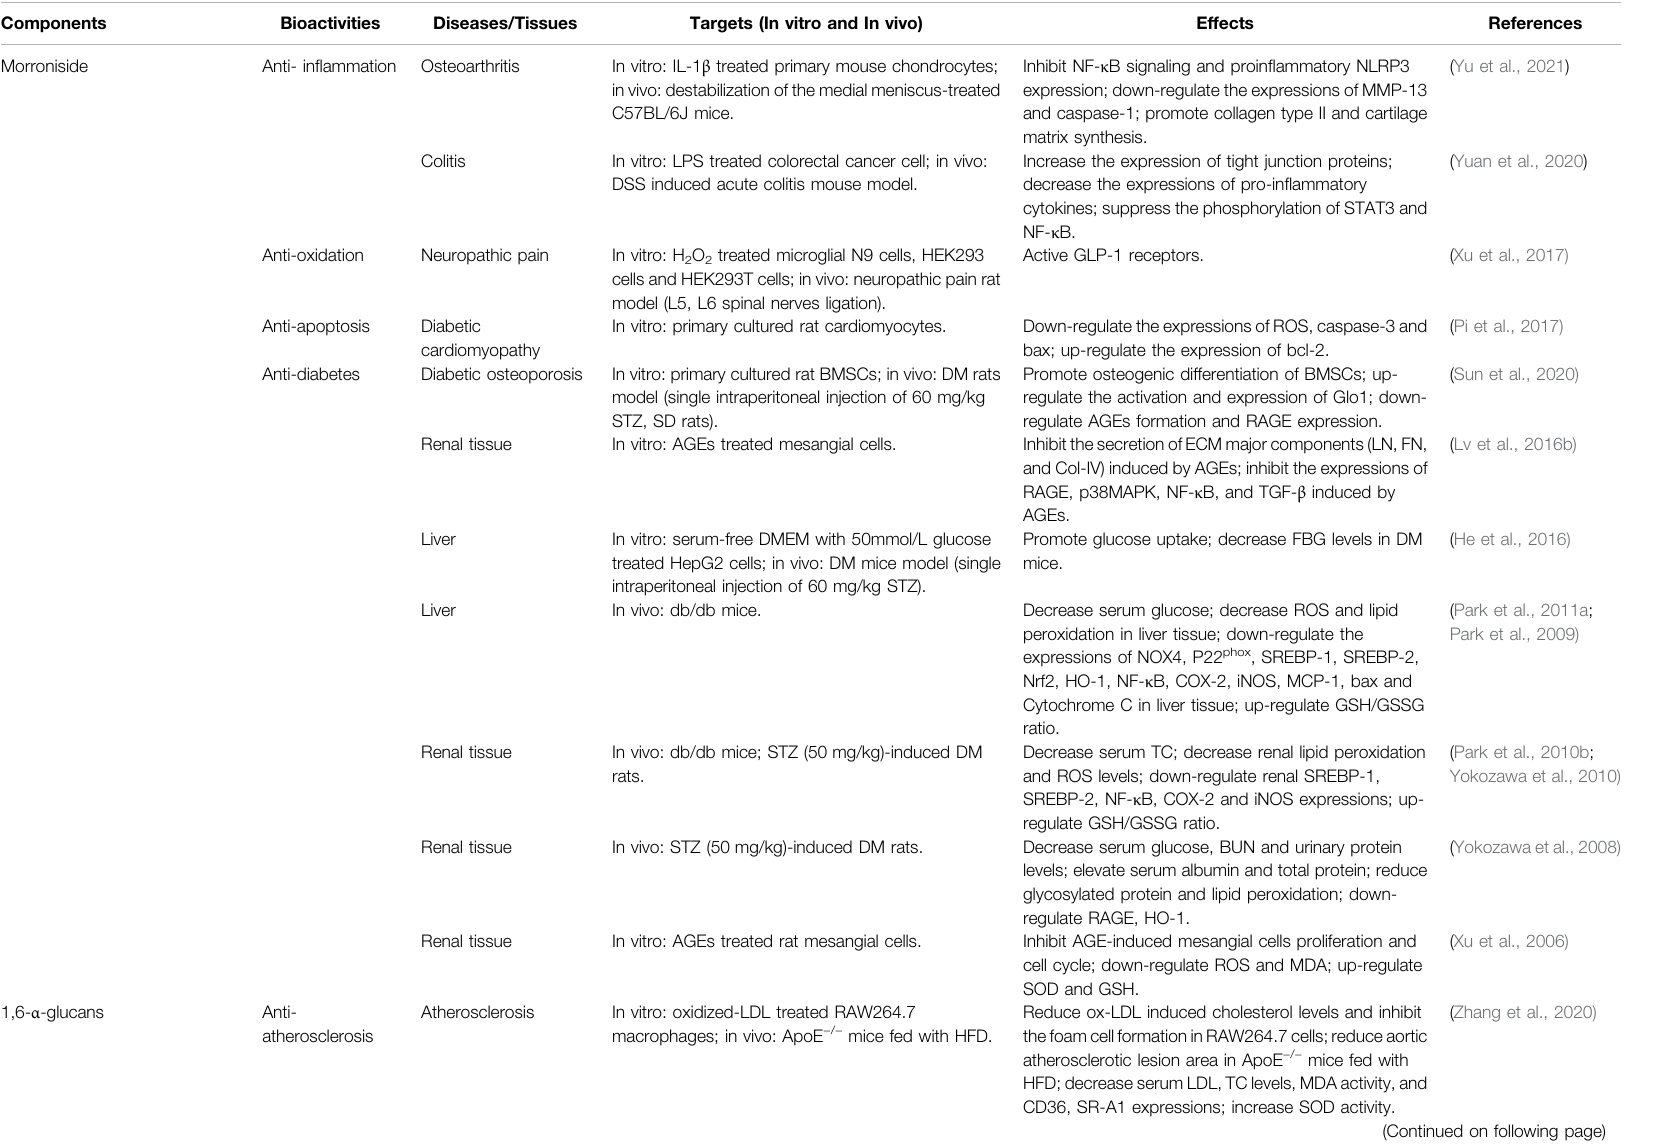
TABLE 1 | Bioactivities of the main components extracted from C. of fi cinalis .